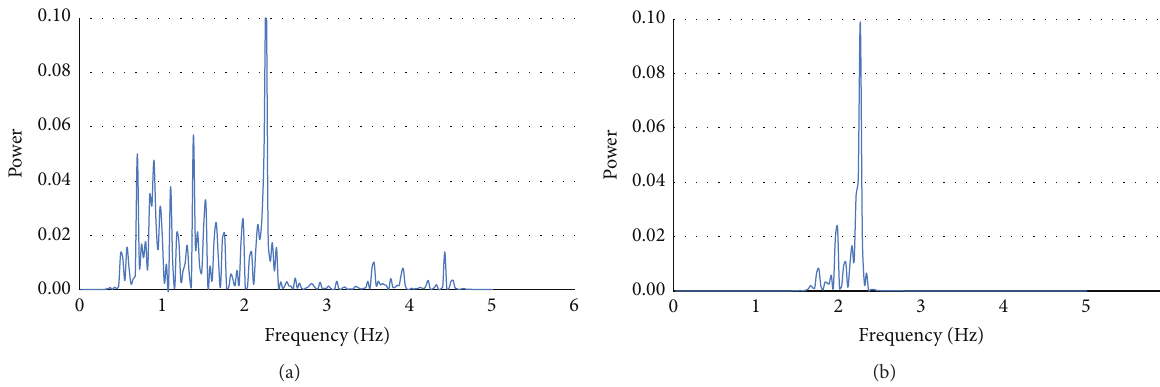
Figure 6: FFT analysis for (a) measured vertical response and (b) filtered vertical